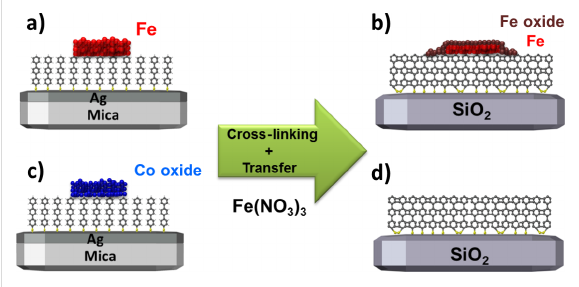
Figure 7: Schematic result of the transfer process. (a) Fe structure on top of a TPT SAM on a Ag(111)/mica sample. (b) Fe structure after cross-linking the SAM and transferring the sample onto bulk SiO 2 . The height decreases, and the structure is oxidized. (c) Cobalt oxide struc- ture on top of TPT on a Ag(111)/mica sample. (d) After cross-linking the SAM and transferring the sample onto bulk SiO 2 , the cobalt oxide structure has vanished